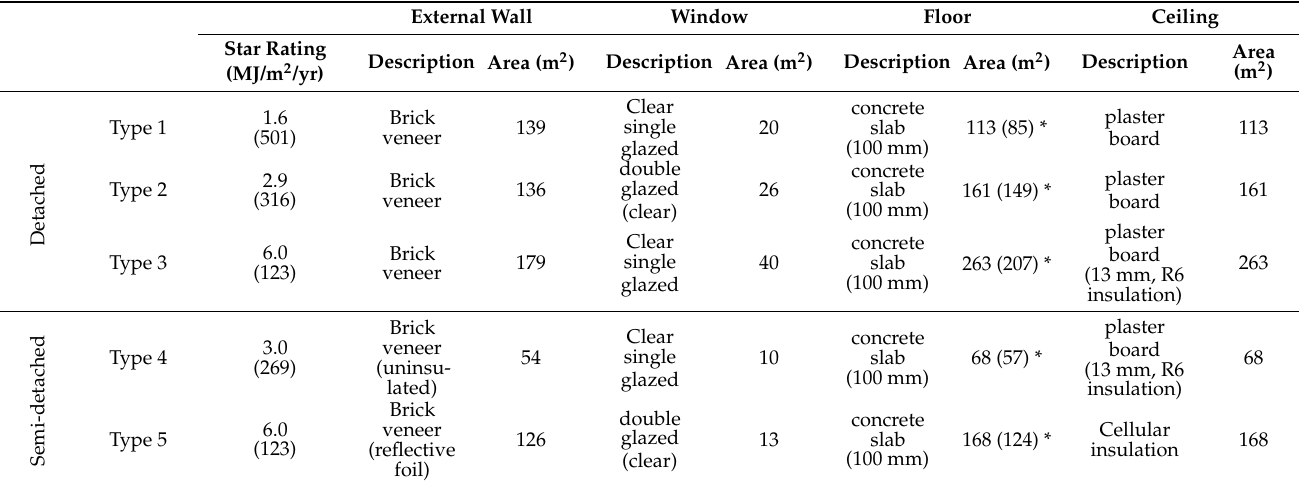
Table 4. Prototype buildings in the City of Greater